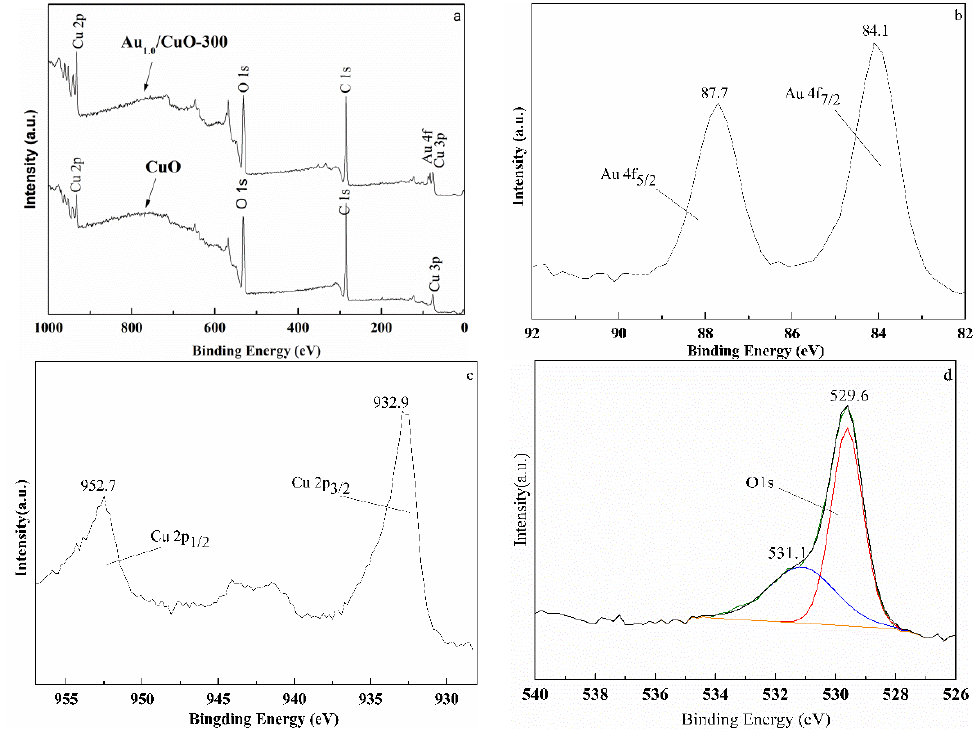
Figure 6. Wide XPS spectrum of CuO and Au 1.0 /CuO-300 ( a ) and high-resolution XPS spectra of Au 1.0 /CuO-300: Au 4f peaks ( b ), Cu 2p peaks ( c ), and O 1s peaks ( d ).